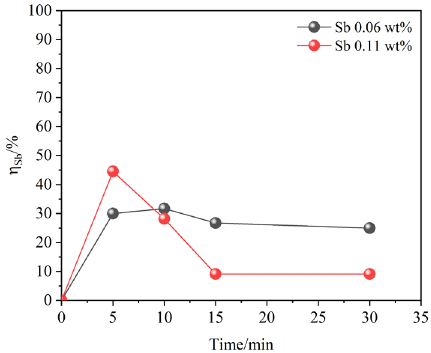
Figure 4. Effect of initial Sb content in molten steel on Sb removal ratio at T = 1873 K, slag = 5 wt%, initial C content = 0.05 wt%, and initial CaC 2 = 20 wt%.